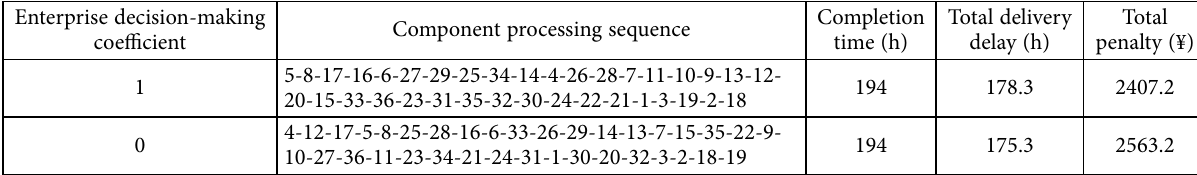
Table 6. Optimization results under different enterprise decision-making coefficients